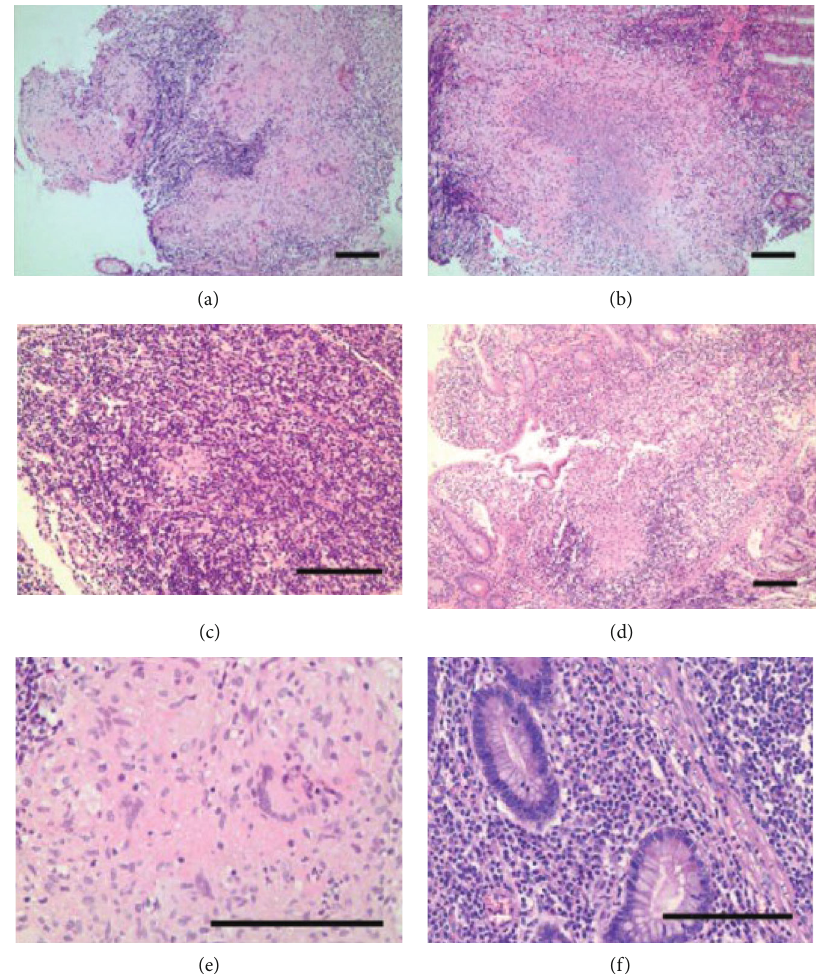
Figure 1: Histological features of intestinal tuberculosis (ITB) and Crohn ’ s disease (CD) discovered in endoscopic biopsy specimens. ITB commonly features several large, con fl uent caseating granulomas (a), with central necrosis (b) and giant cells (e). CD features relatively few, small granulomas (c). Large granulomas in CD are rare, and if present, they are poorly organized (d). Basal plasmacytosis can be seen in CD (f). (Images obtained with permission from Ye et al.